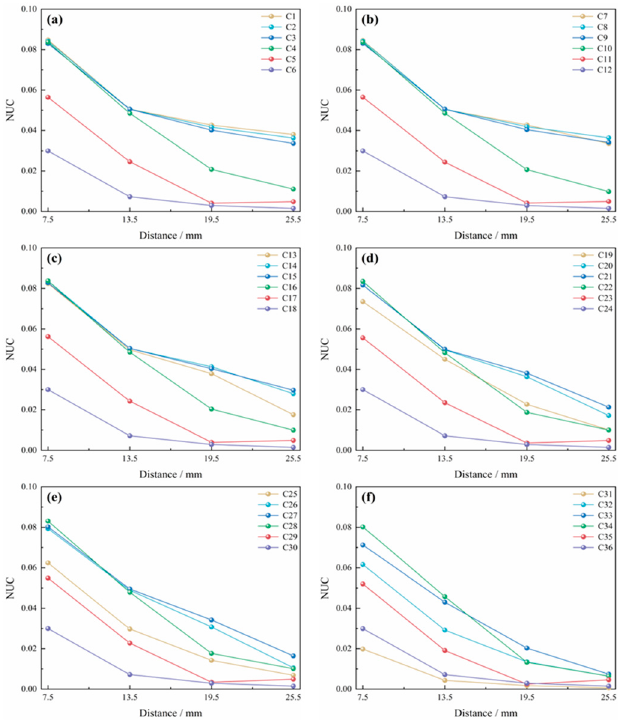
Figure 7. Trend chart of 𝑁𝑈𝐶 value of each section with the increase of mixing path length under thirty-six working conditions. ( a ) working conditions C1–C6; ( b ) working conditions C7–C12; ( c ) working conditions C13–C18; ( d ) working conditions C19–C24; ( e ) working conditions C25–C30; ( f ) working conditions C31–C36.